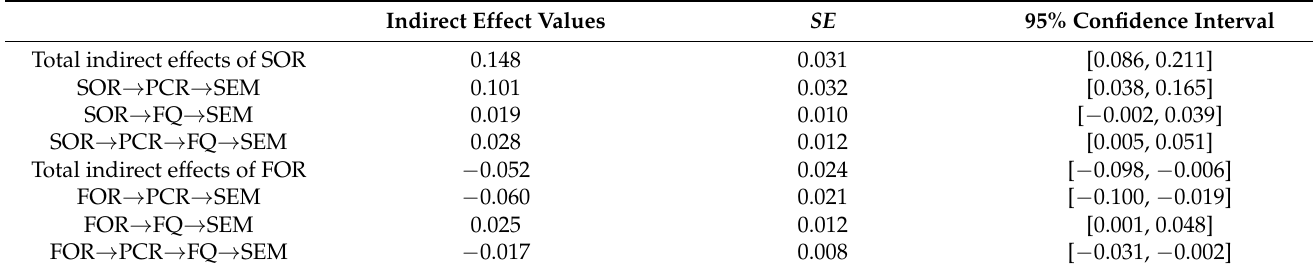
Table 2. Indirect effects of parents’ success- or failure-oriented response on children’s